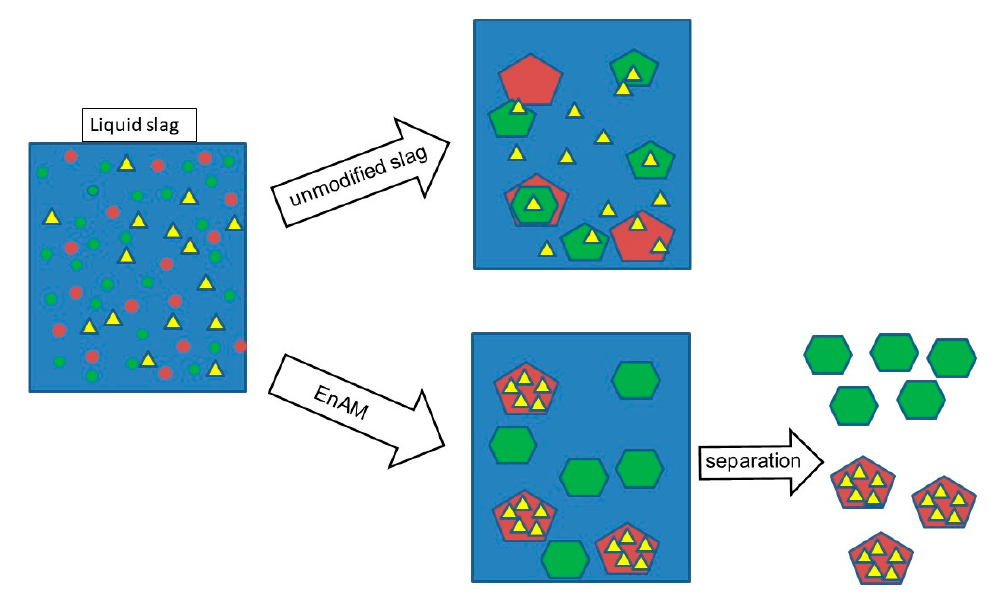
Figure 1. Sketch of engineered artificial minerals (EnAM) formation. On the left, different elements are shown in the liquid slag-matrix: target element (yellow triangle), phase for EnAM (red) and other phases (green). The upper route refers to an unmodified slag–the target element is spread over several different phases and the matrix (blue). The target element is not recovered. The bottom picture illustrates the formation of EnAM. The target element is concentrated in a single phase (red pentagon) that differs physically and chemically from the other phases (green hexagon), and allows for efficient separation and further treatment.